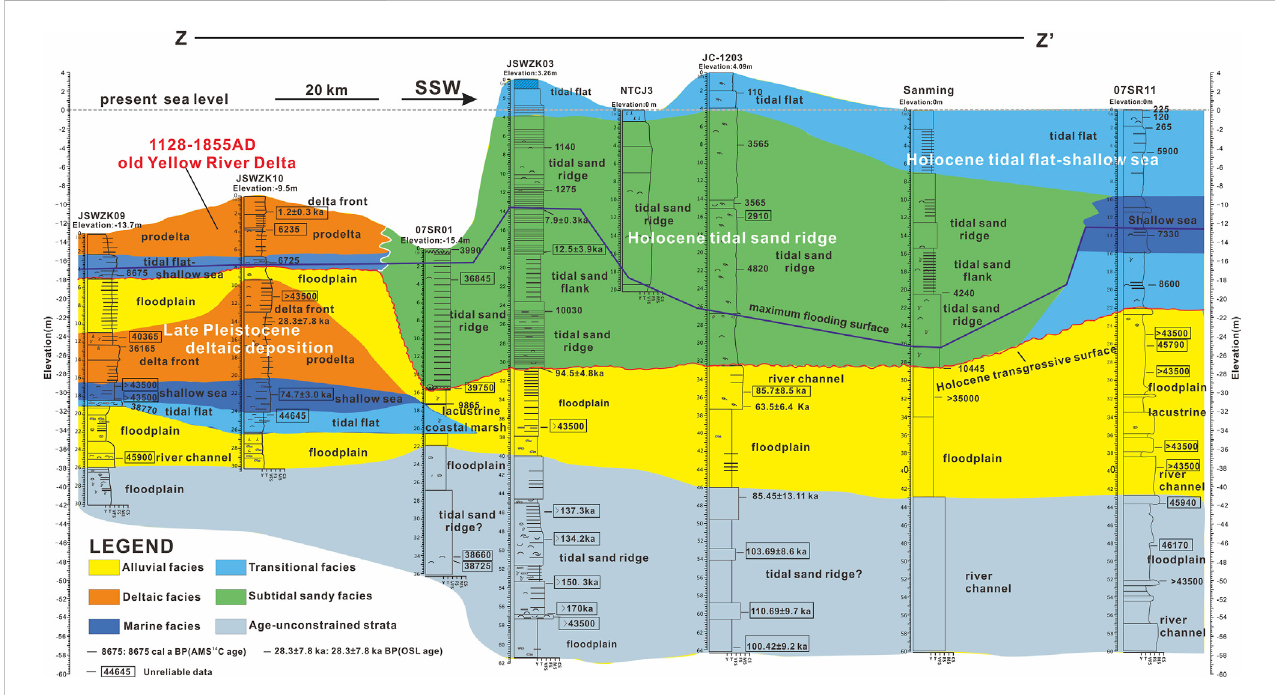
FIGURE 10 Faciesarchitecture alongcoastaltransect Z-Z ′ .Cores 07SR01, NTCJ3,JC-1203, Sanming,and 07SR11 aremodi fi edfrom Yinand Zhang (2010),Zhang X. et al. (2013), Xiao (2015), Wang Y. et al. (2012), and Sun et al. (2015),